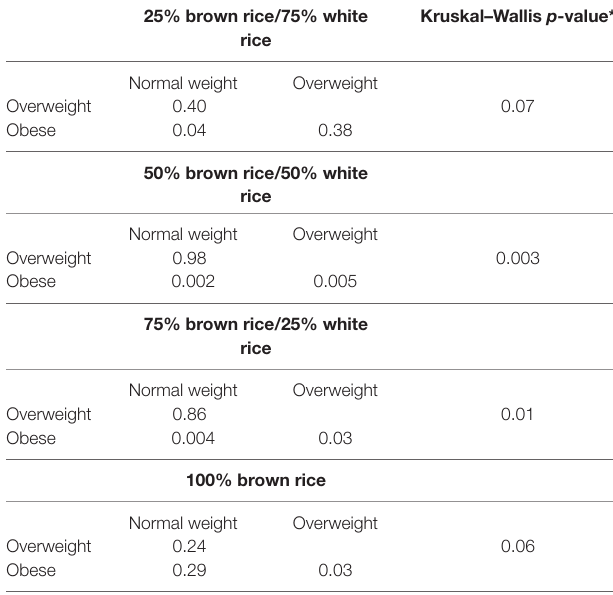
TaBle 6 | Multiple comparisons of mean 2-h postprandial glucose for the rice meals.